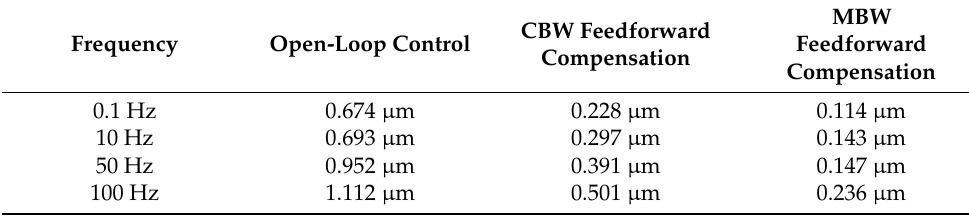
Table 7. RSME of different control methods under different frequency standard sin